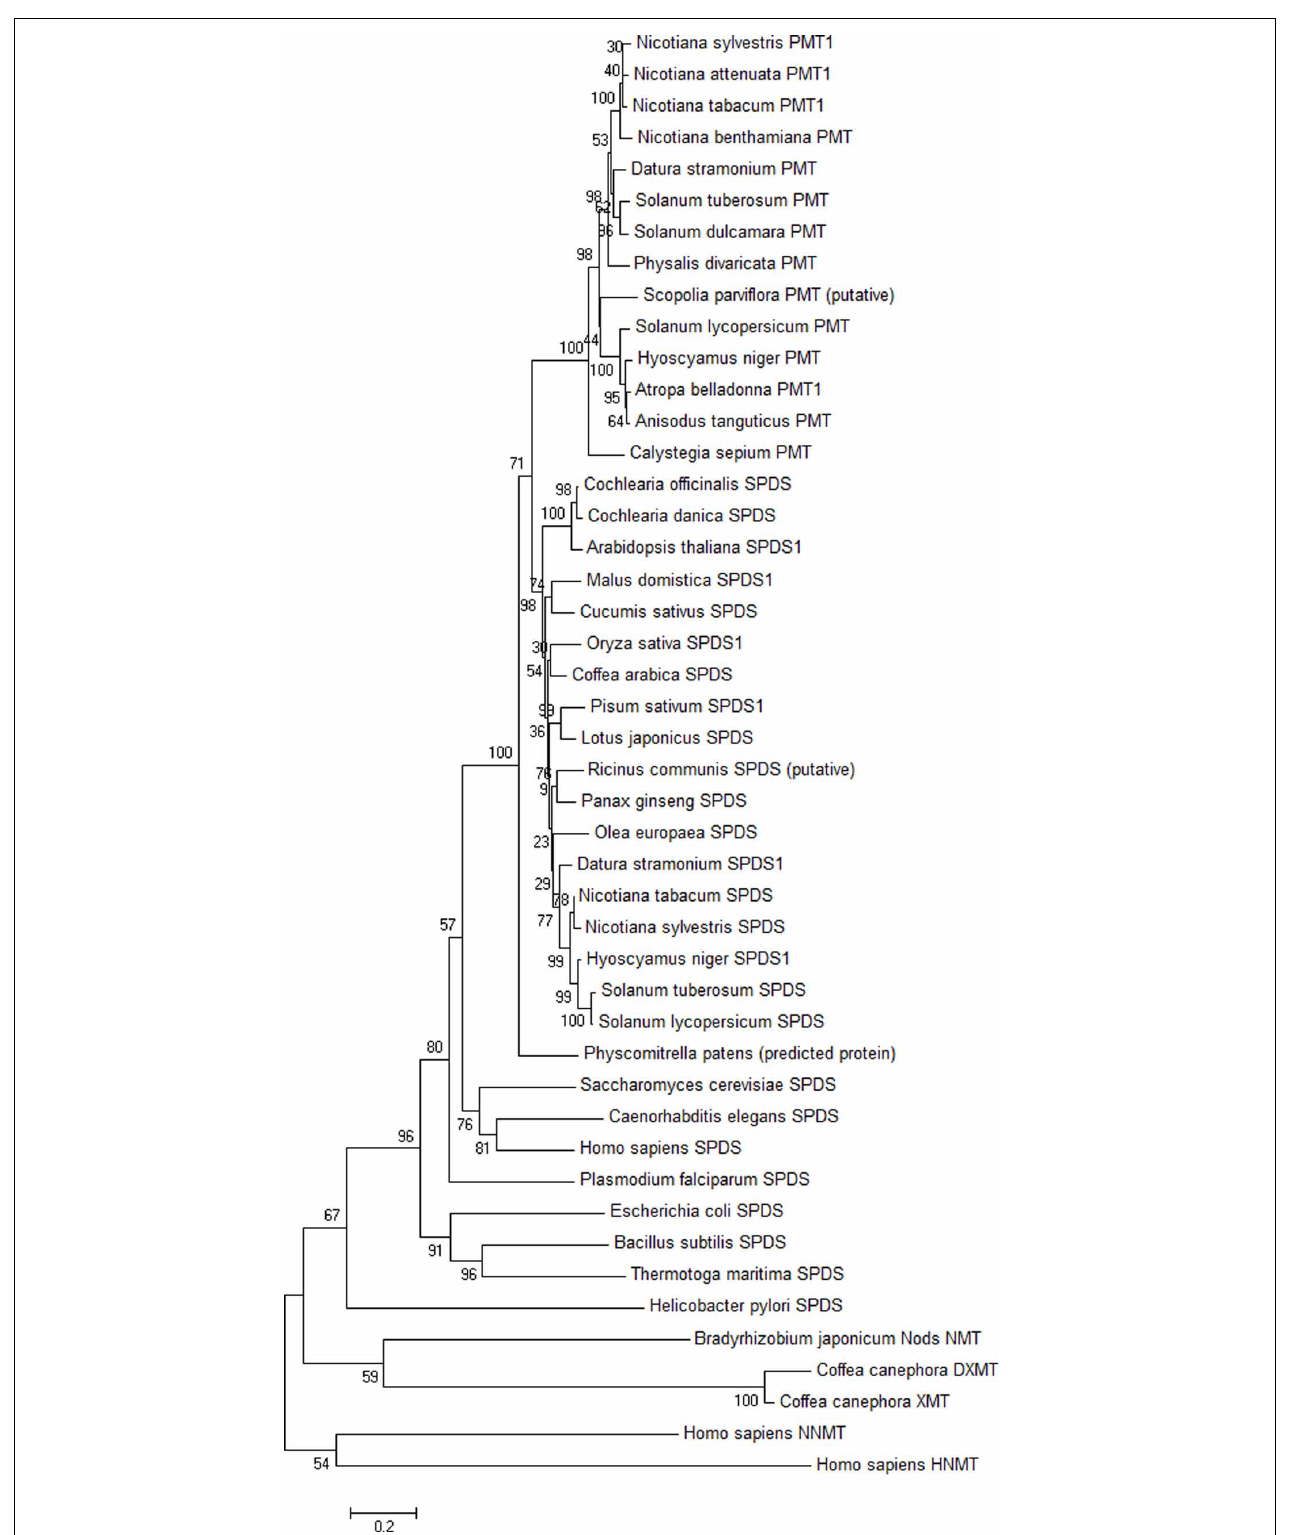
FIGURE 5 | Phylogenetic tree of PMT, SPDS, and N-methyltransferase (NMT) proteins. The unrooted tree was computed with MEGA5 (Tamura et al., 2011) using the Neighbor-Joining method. Accession numbers of the